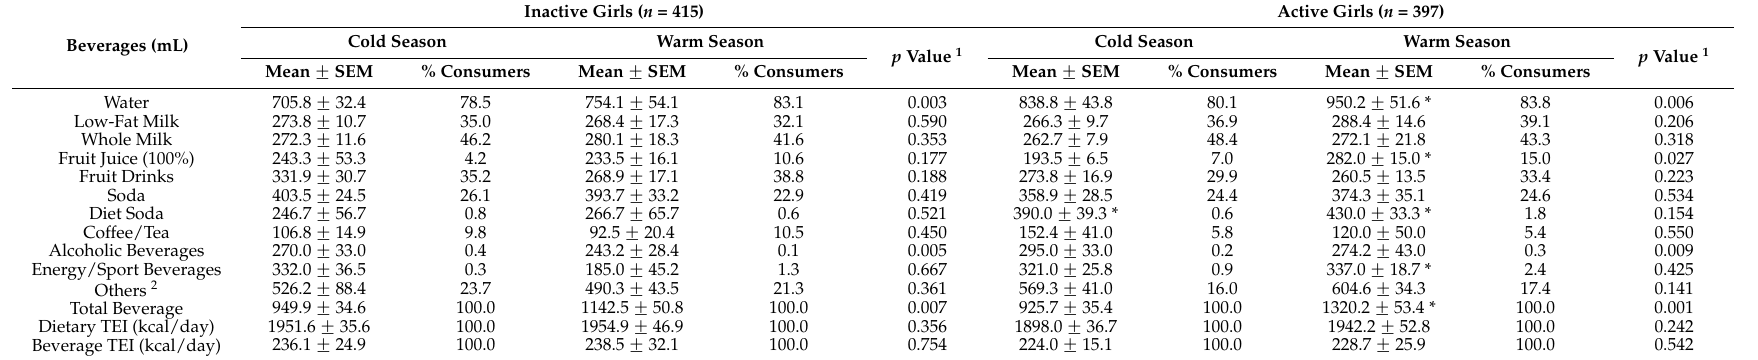
Table 4. Daily beverage (mL), energy intake and percentage of consumers among active and inactive girls according to the